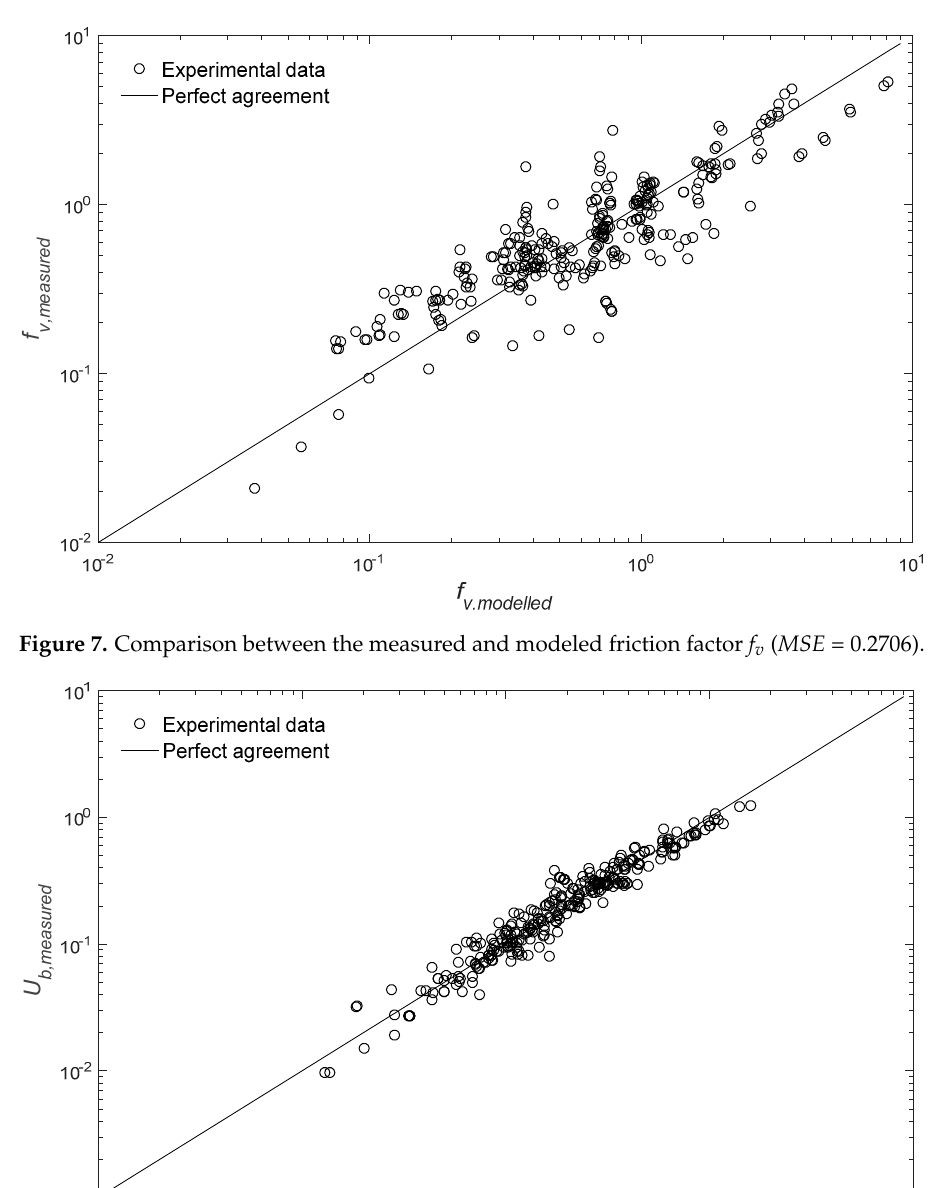
Figure 8. Comparison between the measured and modeled bulk velocity U b ( MSE = 0.0041). For bulk velocity U b , comparison between model and measurements yields MSE = 0.0041 m 2 /s 2 , with maximal departure between model and measured being 0.3581 m/s.